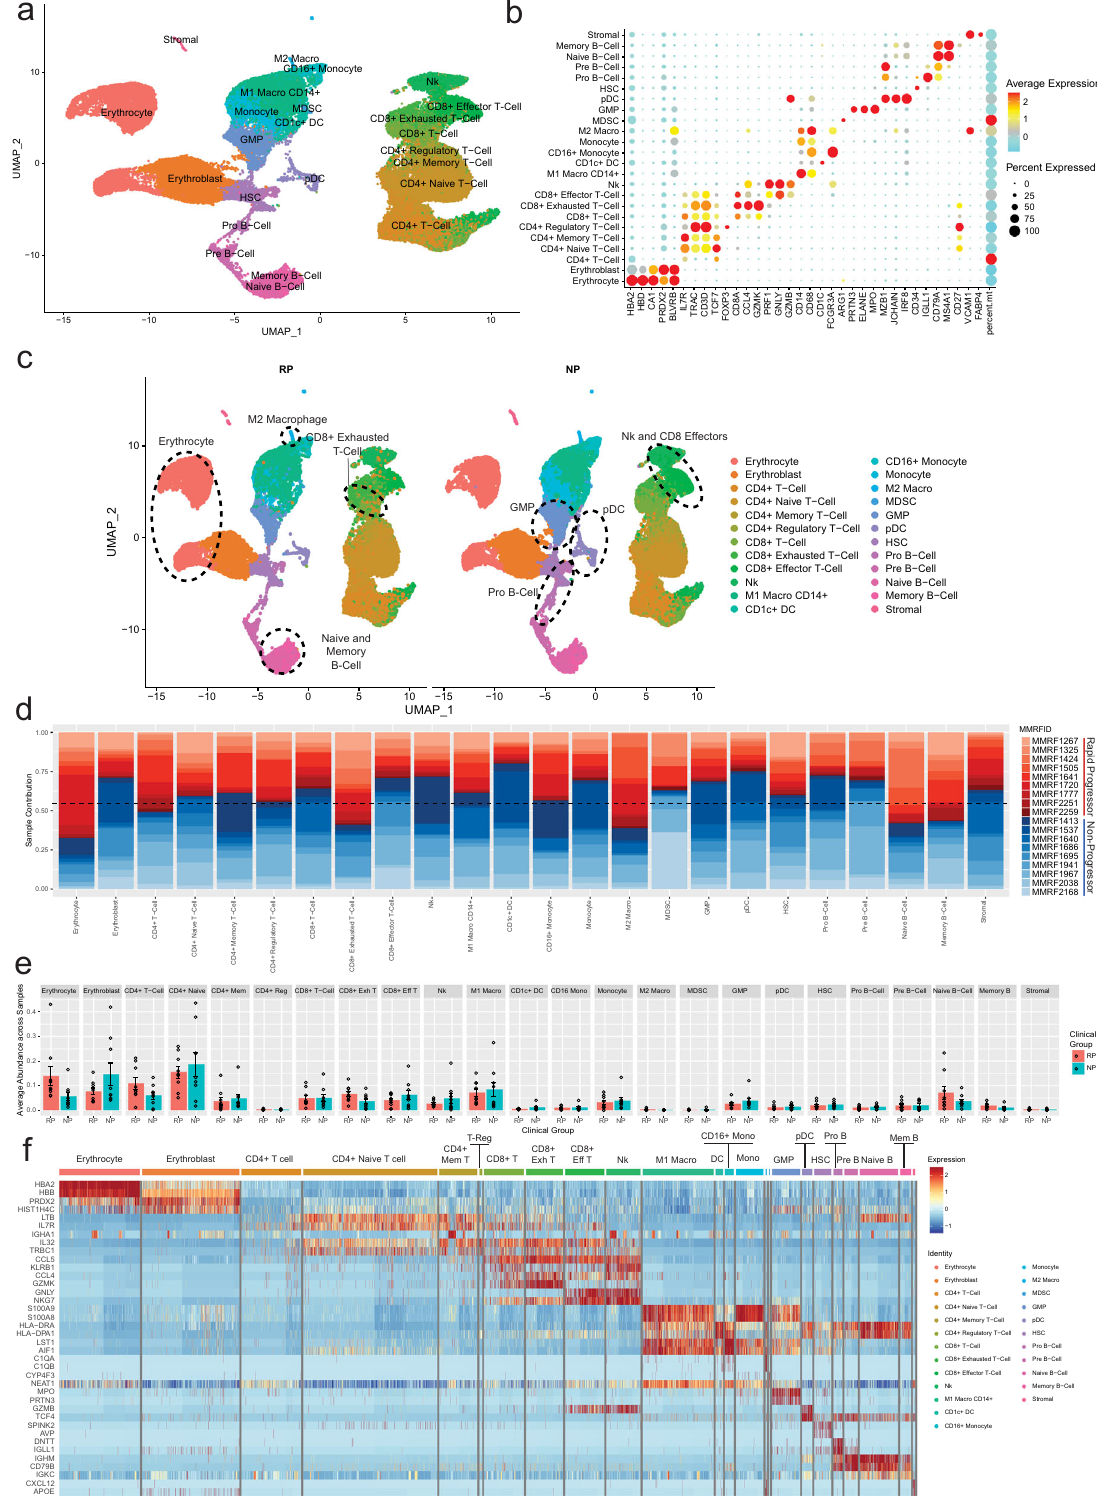
ratio for all cell types. The comparative analysis of cellular proportions among the centers depicted subtle variation, which might be due to differences in the number of cells captured for single-cell assay, sequencing depth, and assays performed. All three centers captured striking similar proportions of pDCs, HSCs, B cells, and